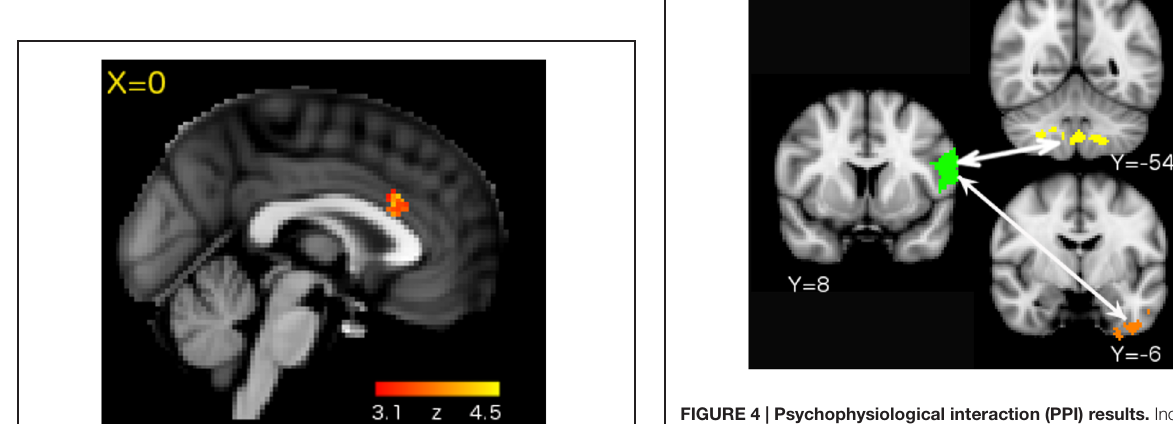
FIGURE 4 | Psychophysiological interaction (PPI) results. Increased functional connectivity between the left BA 44/6 Ventral ROI (seed in green) and cerebellum/brain stem (yellow. Cerebellum peak: 26 − 54 − 44) and left anterior-inferior temporal lobe (orange. Peak: − 28 − 6 − 8) during the concurrent task relative to the consecutive